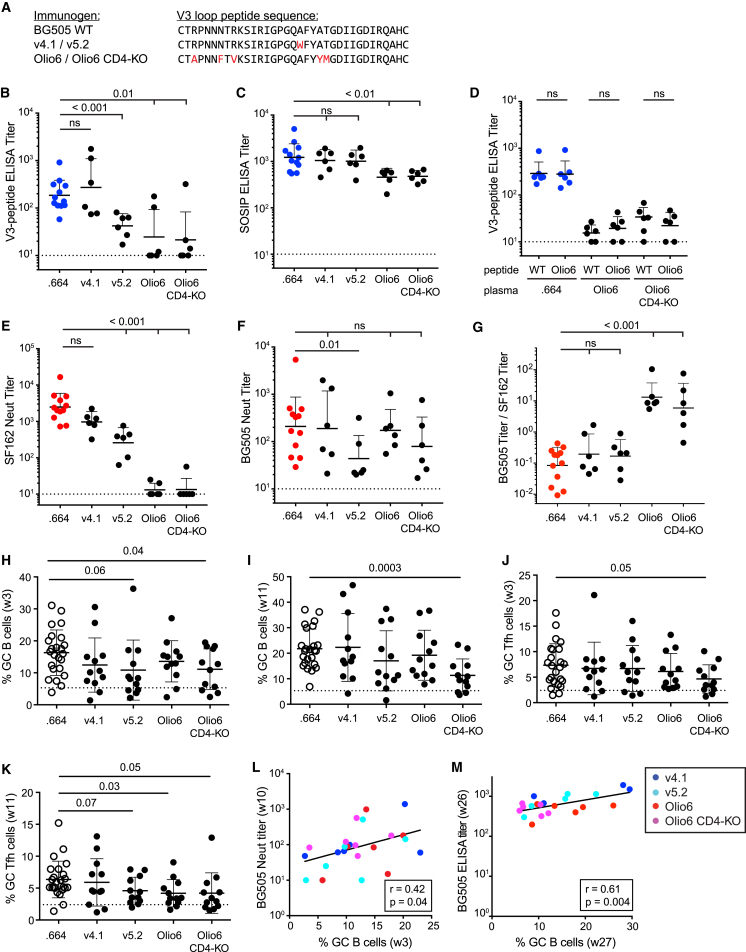
Trimer Stabilization Strategies Can Reduce V3-Loop ImmunogenicityModified BG505 SOSIP and BG505 Olio6 constructs were compared with the BG505 SOSIP.664 immunogen. Immunogens are abbreviated as follows: BG505 SOSIP.664, .664 or BG505 WT; BG505 SOSIP.v4.1, v4.1; BG505 SOSIP.v5.2, v5.2; BG505 SOSIP Olio6, Olio6; and BG505 SOSIP Olio6 CD4-KO, Olio6 CD4-KO. Dotted lines indicate LOD.(A) V3-loop protein sequence of BG505 WT, v4.1, v5.2, Olio6, and Olio6 CD4-KO. Changes are in red.(B) BG505 V3-loop peptide binding IgG titers 2 weeks after the third immunization (week 26; n = 6 or 12).(C) BG505 SOSIP binding IgG titers 2 weeks after the third immunization (week 26; n = 6 or 12).(D) Cross-binding analysis of Olio6 and SOSIP.664 (WT) V3-loop peptides (week 26; n = 6). See Figure 3A.(E–G) Tier 1 SF162 nAb titers (E), BG505 nAb titers (F), and their ratio (G) 2 weeks after the third immunization (week 26; n = 6 or 12).(H and I) GC B cell frequencies after the first (H) and second (I) immunizations (n = 24 or 12).(J and K) GC Tfh cell frequencies after the first (J) and second (K) immunizations (n = 24 or 12).(L) Correlation between GC B cell frequency and BG505 nAb titers. Animals are color coded by immunogen (n = 24).(M) Correlation between GC B cell frequency and BG505 SOSIP binding IgG titers (n = 24).All nAb titer and ELISA binding Ab data represent geometric mean titers with geometric SD. All cell-frequency data represent the mean and SD. See also Figure S3.